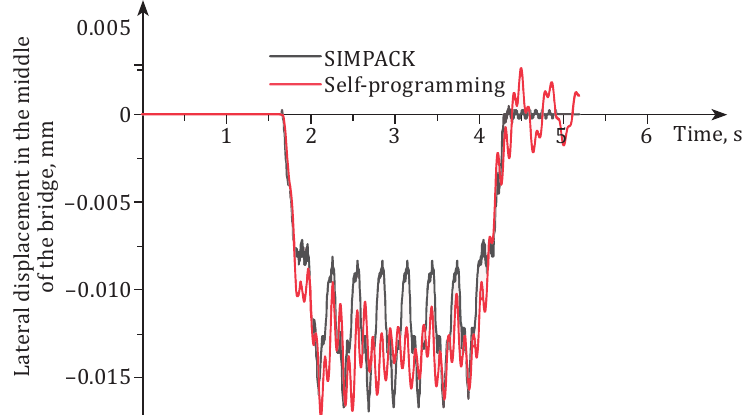
Figure 10. Comparison of lateral displacement time history at the midspan of the